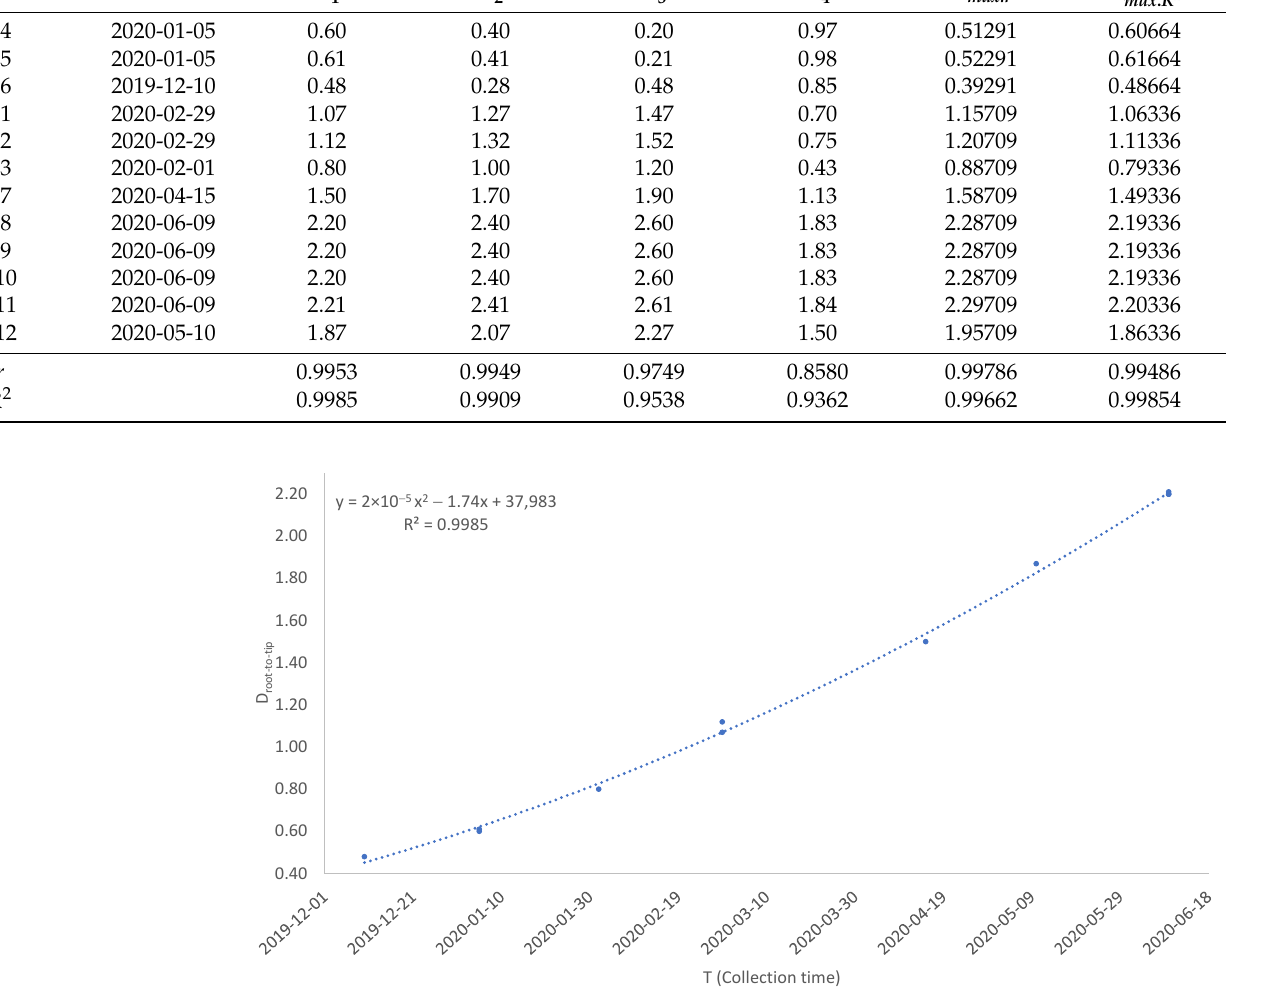
Figure 2. The root-to-tip distance ( D ) increases with viral sample collection time ( T ). Dot color codes are blue for D 1 , orange for D 2 , black for D 3 and red for D 4 . The order-2 polynomial regression line was fitted for D 1 and T only.